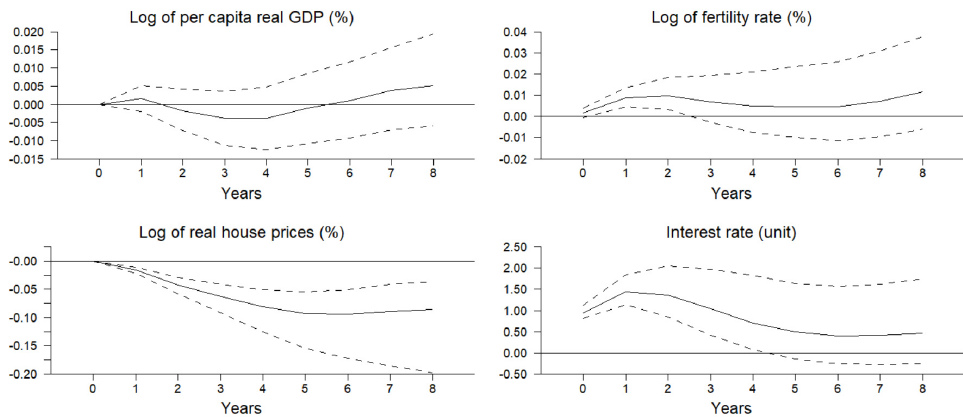
Figure 11 . Responses to an interest rate shock in the baseline SVAR when the fertility rate is ordered last in the model .